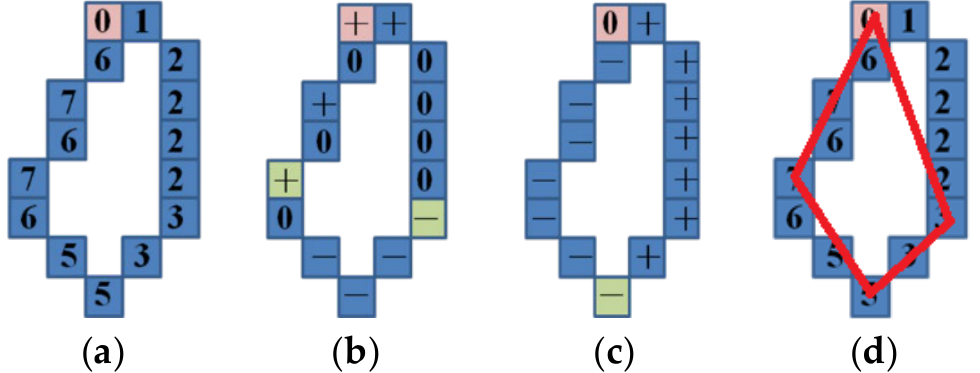
as illustrated in Figure 8b,c, respectively, where the symbols + and—are used to represent the symbols +1 and − 1, respectively.